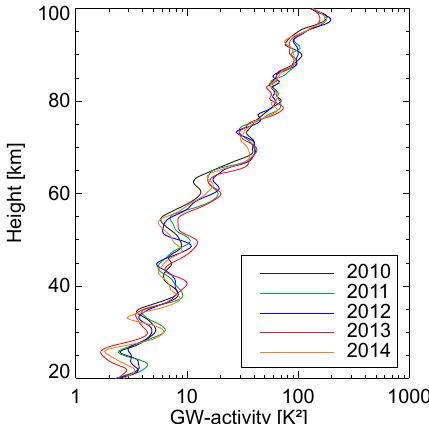
Figure 1. Mean squared temperature residuals for the years 2010 to 2014 (colour-coded). They are derived from TIMED-SABER, data version 2.0 by using a cubic spline routine with equidistant sampling points for detrending. The distance between two spline sampling points is 10km. All vertical SABER temperature profiles which were retrieved between 44 and 48 ◦ N and 5 and 15 ◦ O are used (that means approximately 30–50 profiles per month and ap- proximately 500 profiles per